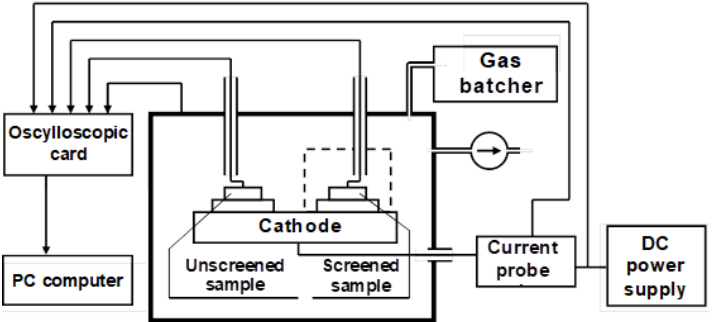
Figure 3. Diagram of the setup for experimental analysis of the effect of screens on the glow-discharge nitriding